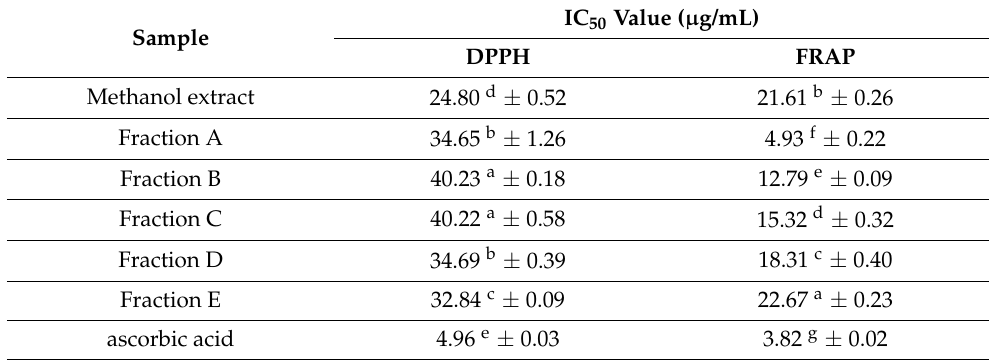
Table 2. IC 50 value of Patiwala ( Lantana camara ) leaf fraction using the DPPH and FRAP method.